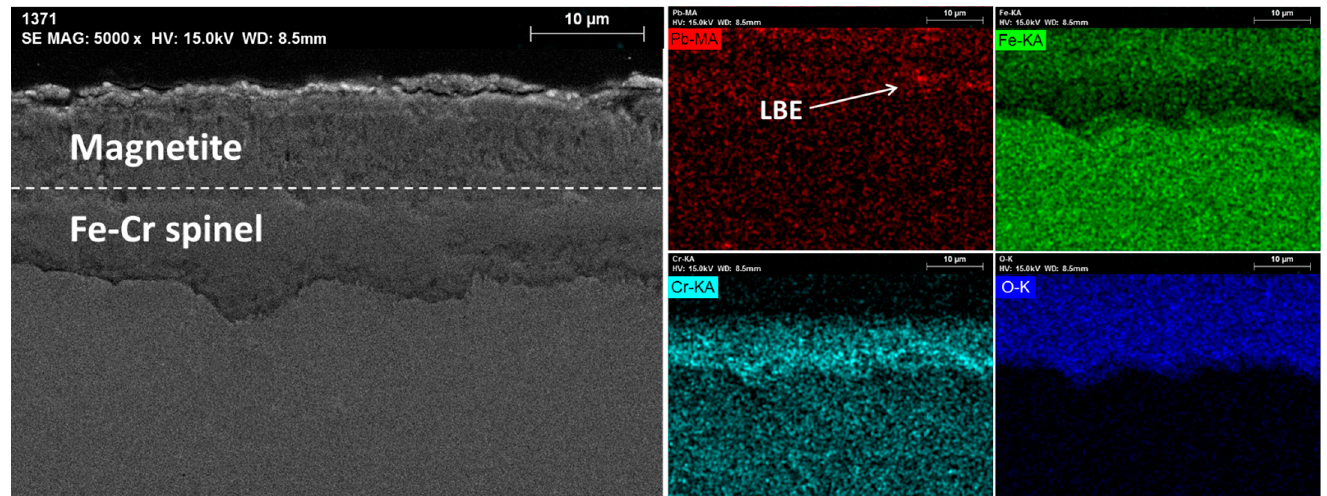
Figure 8. Stable duplex oxide layers on HT9 after 1000 h at 600 °C.